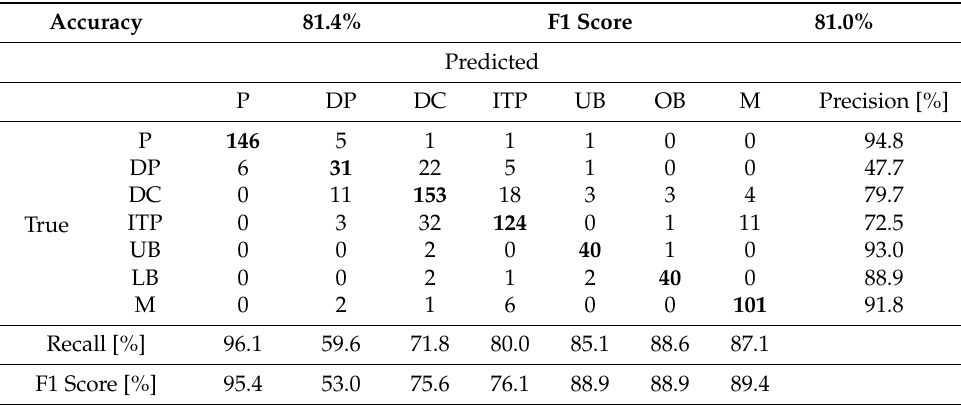
Table 5. Confusion matrix of classification strategy 3 (hierarchical).